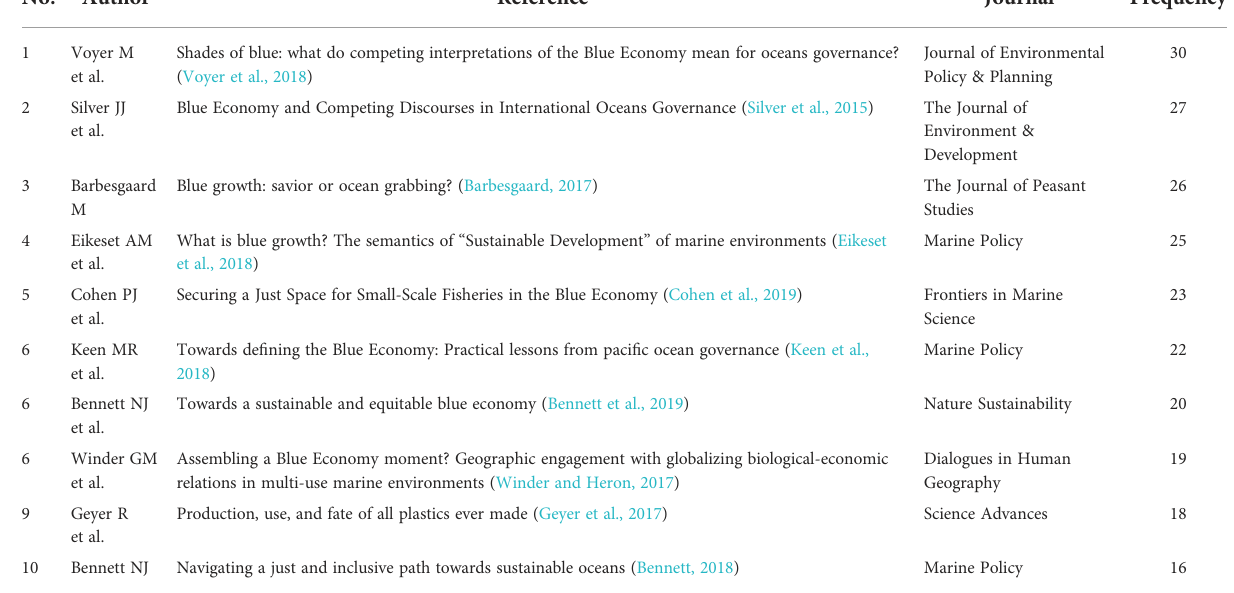
TABLE 8 Based on the top 10 cited articles by